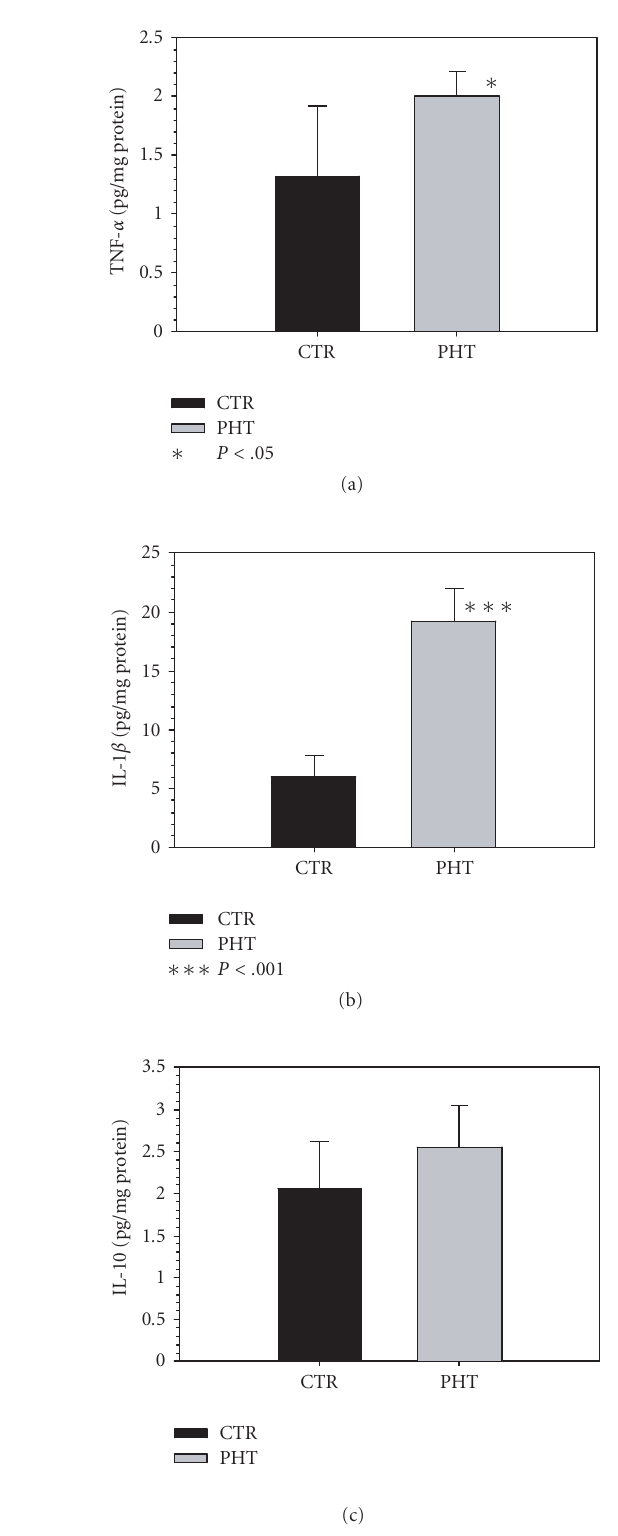
Figure 2. Concentrations of (a) TNF- α , (b) IL-1 β , and (c) IL- 10 in the ileum of control rats (Group I) and of rats with triple stenosing ligation of portal vein (TSLP) (Group IIb) after 28 days of evolution.